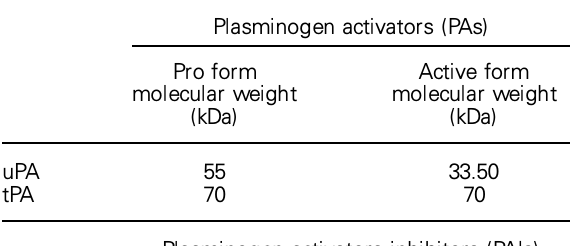
Table 1. Plasminogen activators and their inhibitors (adapted from Ref. 311) Plasminogen activators (PAs) Pro form molecular weight